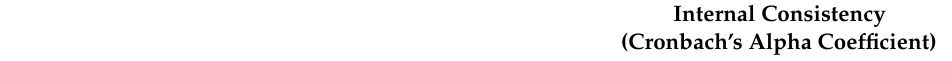
Table 1. Reliability by Internal Consistency of the Five-to-Fifteen (FTF) Questionnaire from Previ- ous